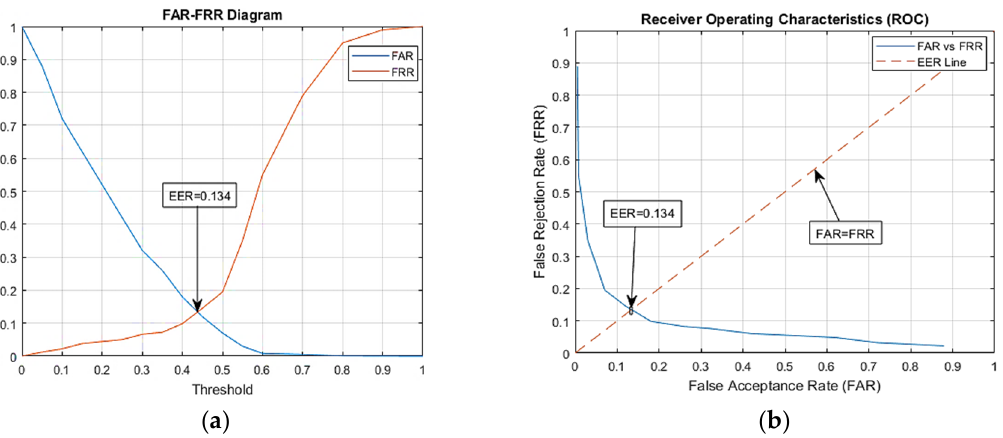
Figure 12. Performance graph for proposed method. ( a ) % Error for threshold distance ( b ) ROC curve.